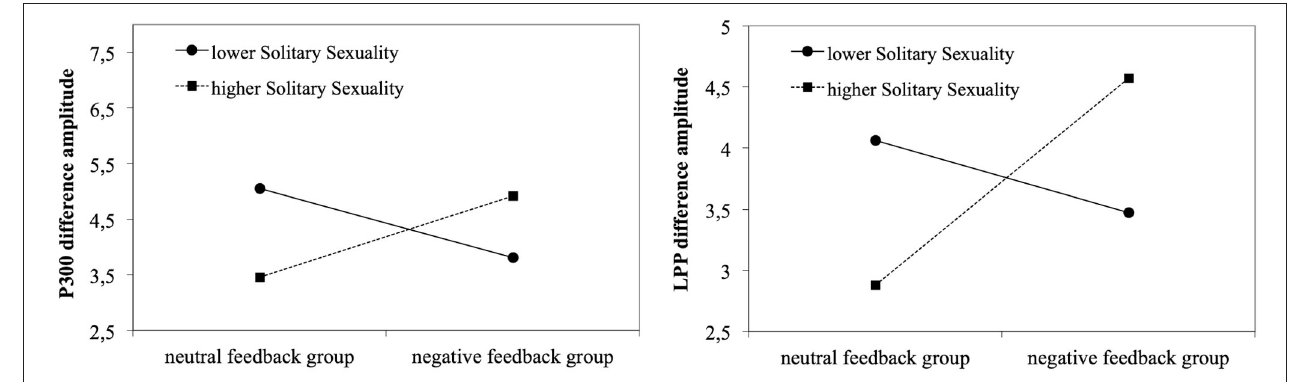
FIGURE 4 | Negative feedback and solitary sexuality predicting P300 (left) and LPP amplitudes (right) toward pornographic pictures (minus neutral